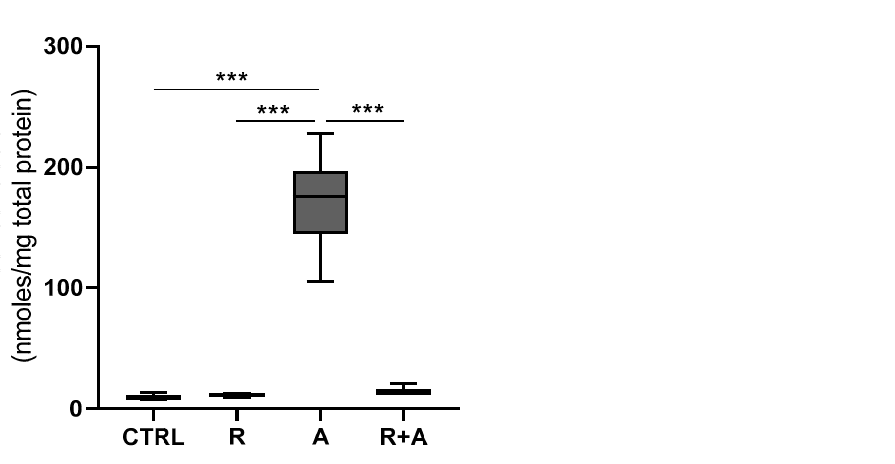
Figure 6. Lipid peroxidation. Box and whiskers plot reports the MDA content in the four different experimental conditions. The statistical comparisons were established between the median MDA concentration in cells exposed to AFB1 and the median MDA concentration observed in all other experimental conditions. Data are expressed as median concentration and data distribution (i.e., quartiles). For each experimental condition, six independent cell culture experiments were performed. CTRL condition corresponds to cells exposed to PCB126 only. R = resveratrol; A = AFB1. *** p < 0.001 (one-way ANOVA, followed by Dunnett’s multi-comparisons test).